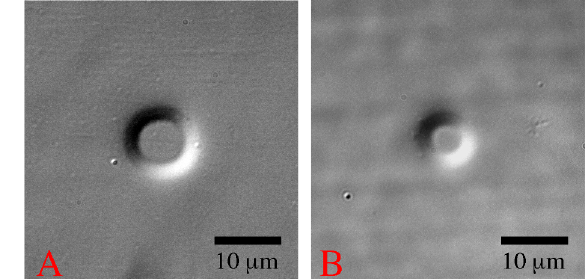
Figure 1. Picture of the intermediate mask made of aluminium on a 75 x 50 mm glass.